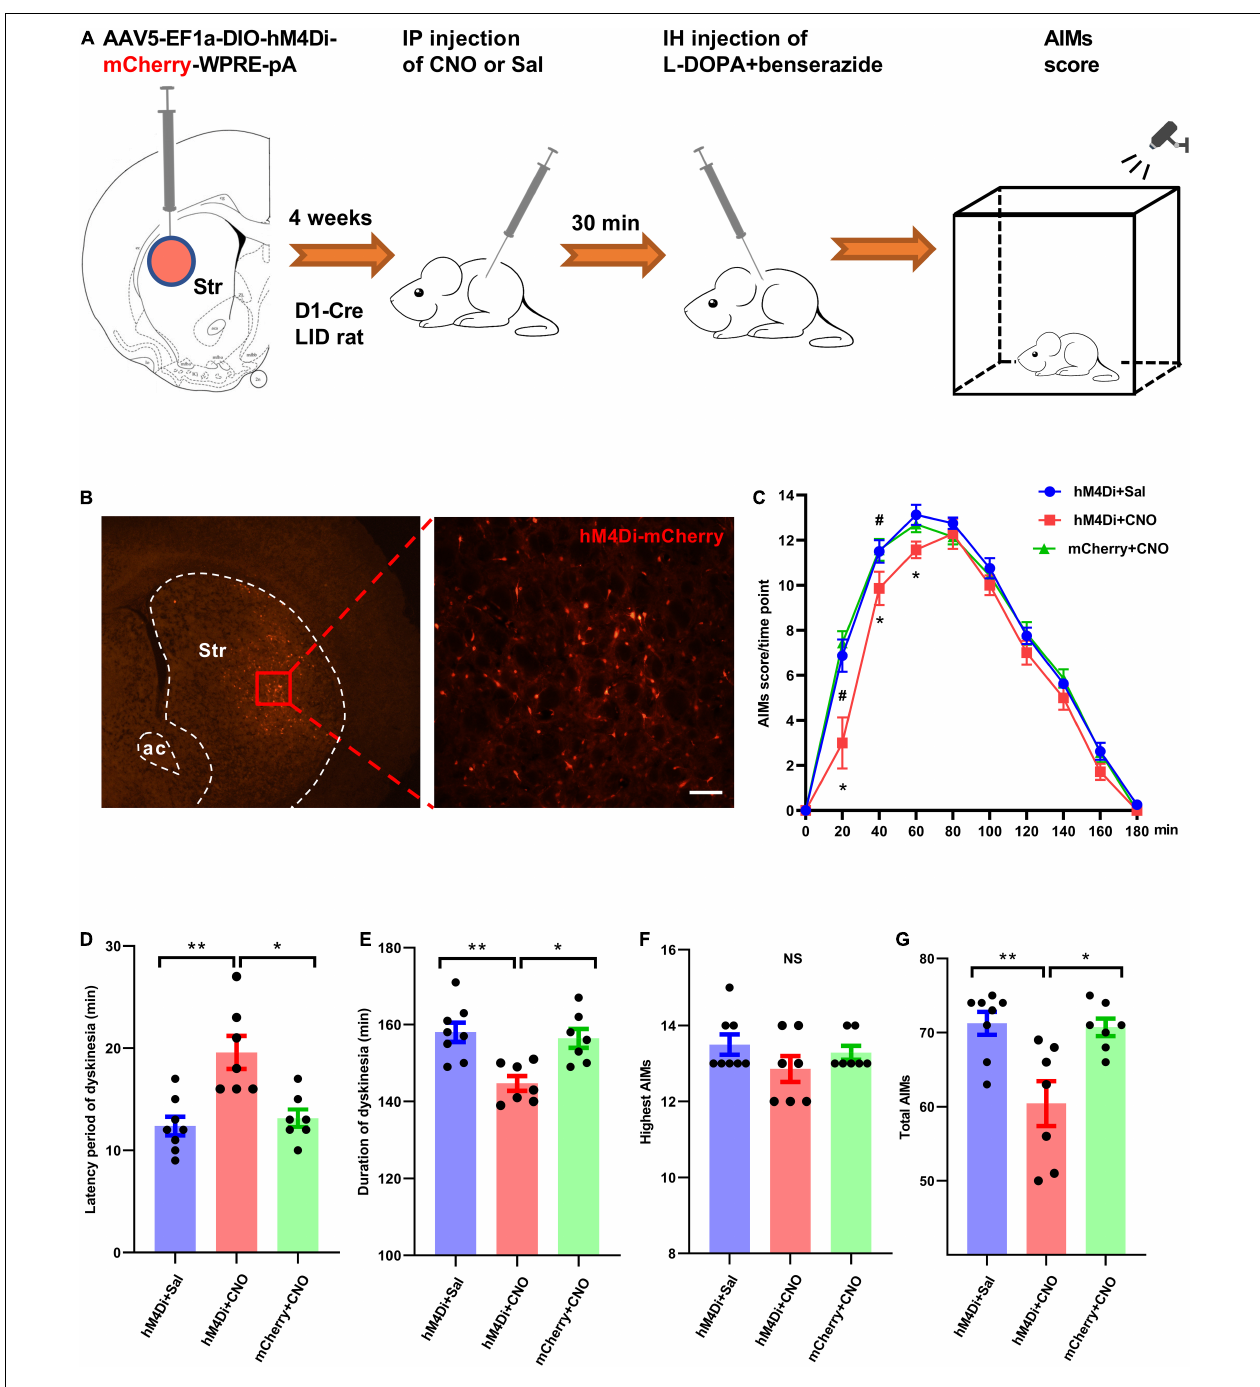
FIGURE 5 | Chemogenetic silencing of striatal D 1 + neurons suppressed dyskinetic movements in rats with levodopa-induced dyskinesia (LID). (A) Experimental design of the chemogenetic assay using stereotaxic injection of Cre-dependent AAV to express hM 4 Di-mCherry or mCherry in striatal D 1 + neurons. (B) Representative photomicrographs of striatal brain slice of a D 1 -Cre rat following intra-striatal infusion of AAV-DIO-hM4Di-mCherry. (C) The time-course plot of Abnormal Involuntary Movement scale (AIMs) scores per time point at intervals of 20 min following levodopa administration and intraperitoneal injection of clozapine-N-oxide (CNO) or saline (Sal) in dyskinetic rats from different groups ( n = 8 for hM 4 Di+Sal group, n = 7 for hM 4 Di+CNO group and mCherry+CNO group; two-way repeated measures analysis of variance (ANOVA) with post-hoc Holm-Sidak method: F ( 2 , 219 ) = 8.641, P = 0.002; hM 4 Di+CNO vs. hM 4 Di+Sal: * P < 0.01; hM 4 Di+CNO vs. mCherry+CNO: # P < 0.01). Comparison of different parameters of dyskinetic behaviors among hM 4 Di+Sal ( n = 8), hM 4 Di+CNO ( n = 7), and mCherry+CNO ( n = 7) groups ( D–G ; One-way ANOVA with post-hoc Holm-Sidak method: F ( 2 , 21 ) = 11.361, P < 0.001 (D) ; F ( 2 , 21 ) = 9.402, P = 0.001 (E) ; F ( 2 , 21 ) = 1.457, P = 0.258 (F) ; F ( 2 , 21 ) = 8.744, P = 0.002 (G) ; * P < 0.01, ** P < 0.001, NS, not significant; IP,